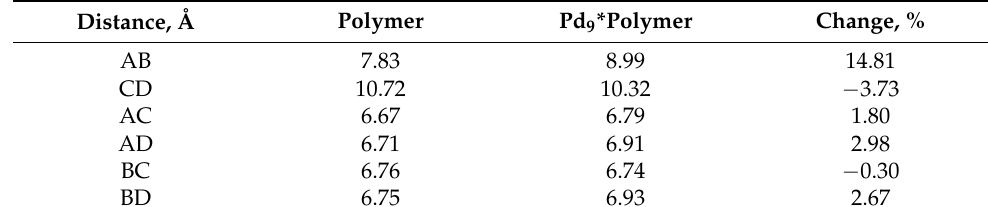
Table 5. Structure parameters of the polymer micropore in case of Pd 9 incorporation.